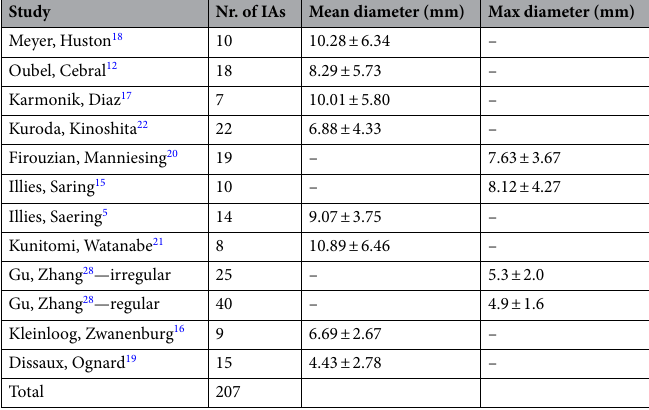
Table 3. Study population of the included studies. ‘—’: not mentioned.